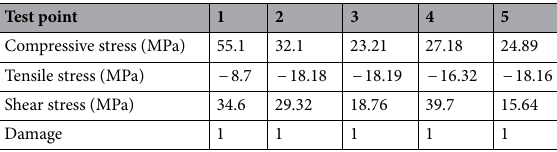
Table 4. The results of the test points.